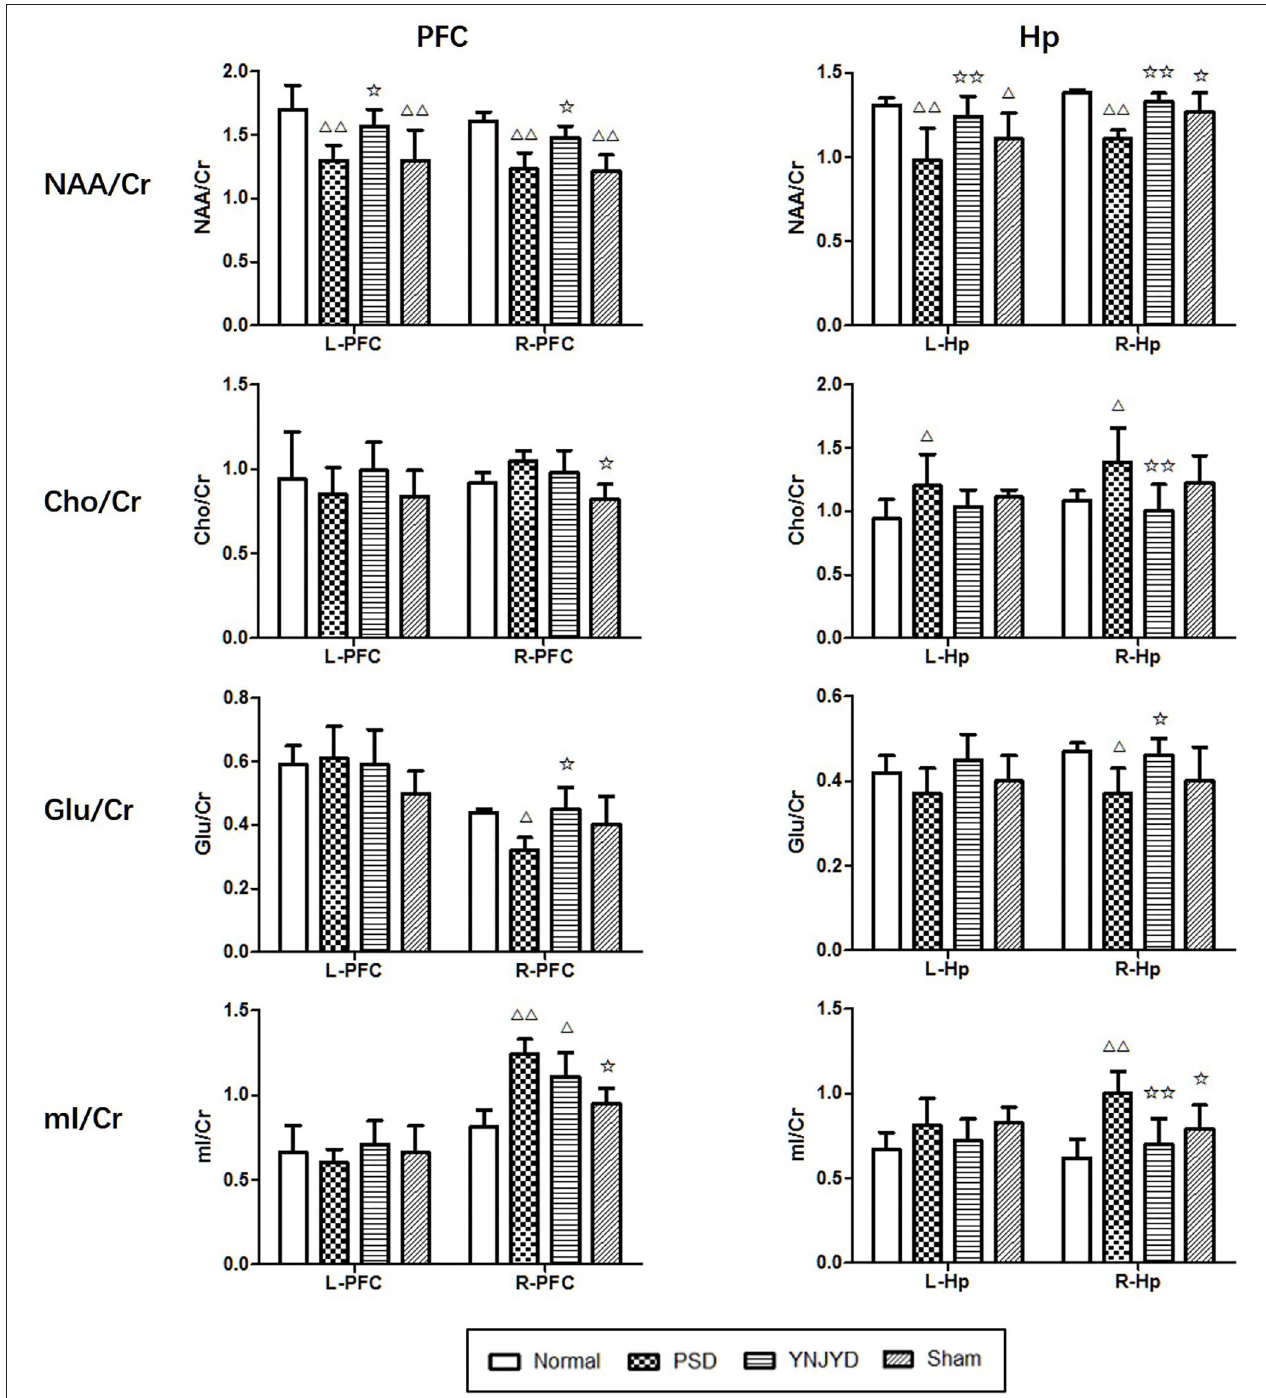
FIGURE 9 | Effects of yi-nao-jie-yu decoction (YNJYD) and post-stroke depression (PSD) on the relative concentrations of brain metabolites, including N-acetyl aspartate (NAA), choline (Cho), glutamate (Glu), and myo-inositol (mI) ratios in the left (L) and right (R) side of the prefrontal cortex (PFC; left column), and the left and right side of the hippocampus (HP; right column) of normal, PSD, YNJYD-treated, and sham-operated rats. The data are presented as means ± SD. 1 P < 0.05, 11 P < 0.01 vs. normal rats; 9 P < 0.05, 99 P < 0.01 vs. PSD rats.